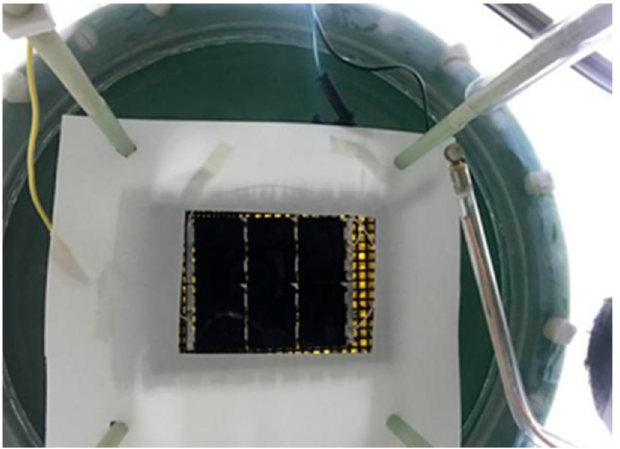
Figure 4. Physical picture of electrostatic discharge test of solar array induced by ESD EMP.